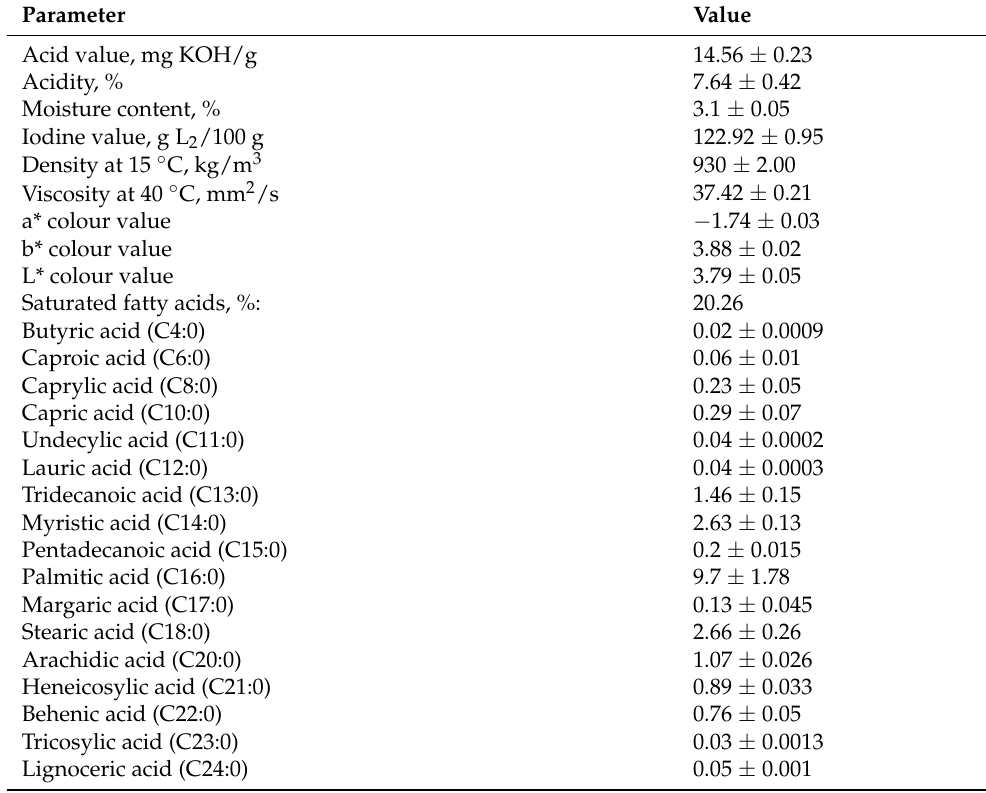
Table 3. Properties of salmon